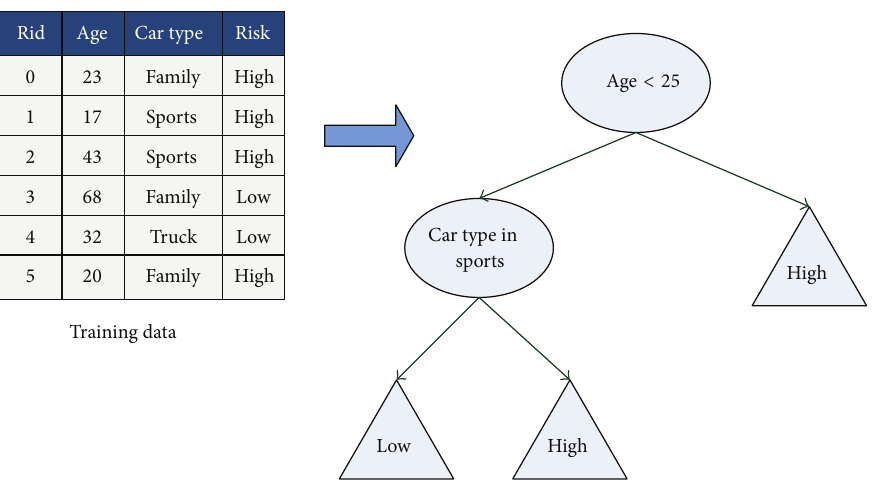
Figure 1: An example of decision